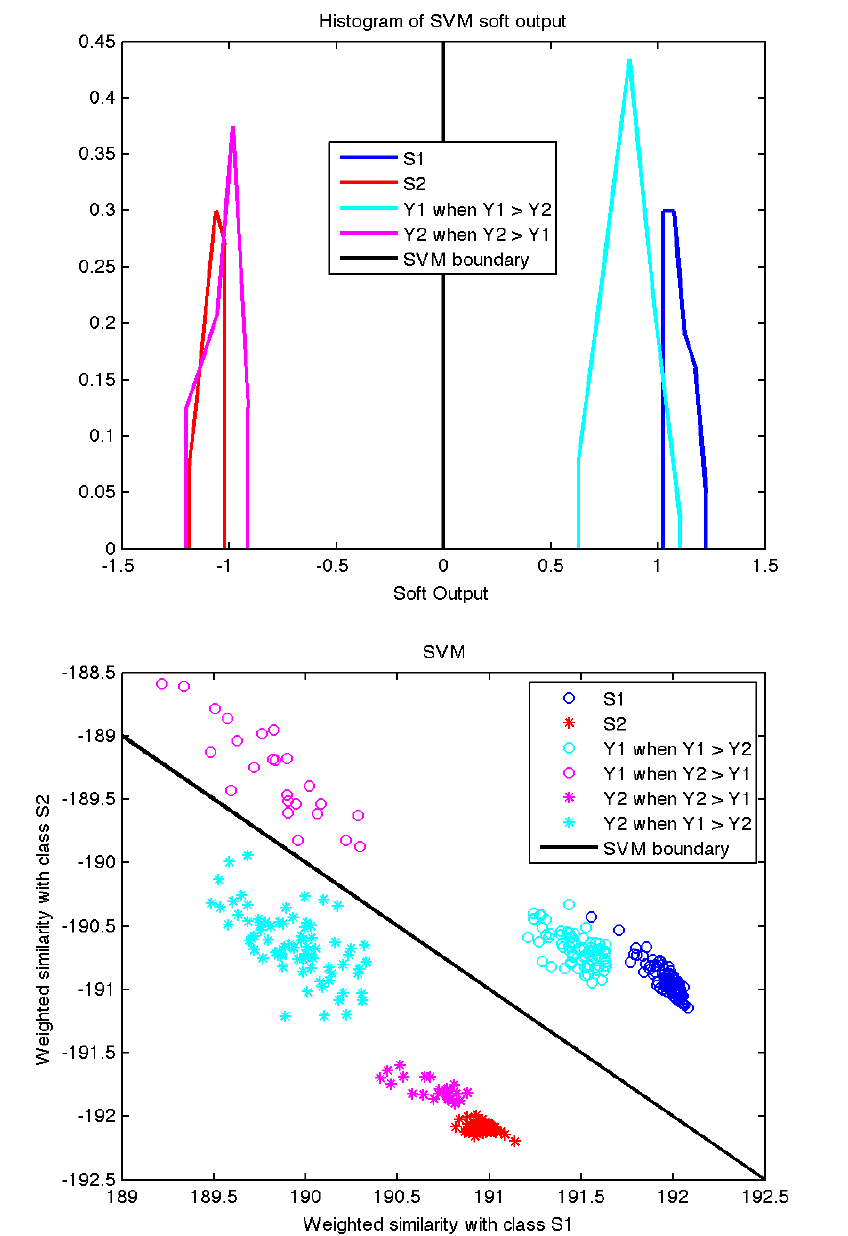
Figure 6. Results of the classification with support vector machine (SVM) and the Kullback–Leibler (KL) kernel. The top plot is a histogram of the classifier output for all the sets of samples. The bottom plot shows a scatter plot of training and test pulses in the 2D space defined by the two sums in Equation